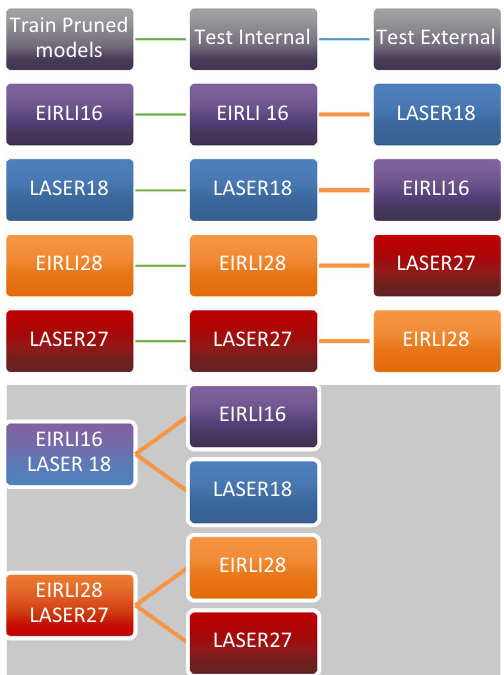
Figure 3. Visual schematic of strategy for model training and testing on internal and external cases from each dataset. Aggregated dataset models (depicted on gray background) reported in Supplemental